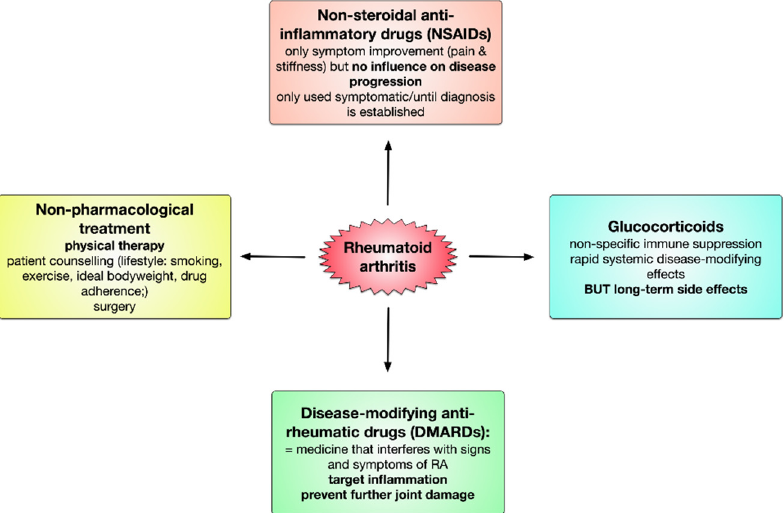
Figure 4. Overview over the available treatment strategies for RA patients. The possible treatments for RA are divided into four main strategies. Non-pharmacological treatments include a combination of physical therapy, patient counseling in lifestyle factors, and surgical procedures to remove and/or replace the affected joint and bone areas. Non-steroidal anti-inflammatory drugs (NSAIDs) are usually used only for symptomatic treatment and/or until the RA diagnosis is established since these drugs reduce pain and stiffness in the affected patients but have no influence on disease progression. In contrast to this, non-specific immune system suppression via the application of glucocorticoids has rapid disease-modifying e ff ects but its long-term usage is limited due to severe side-e ff ects. Finally, disease-modifying anti-rheumatic drugs (DMARDs) are used to target inflammation and prevent further joint damage and disease